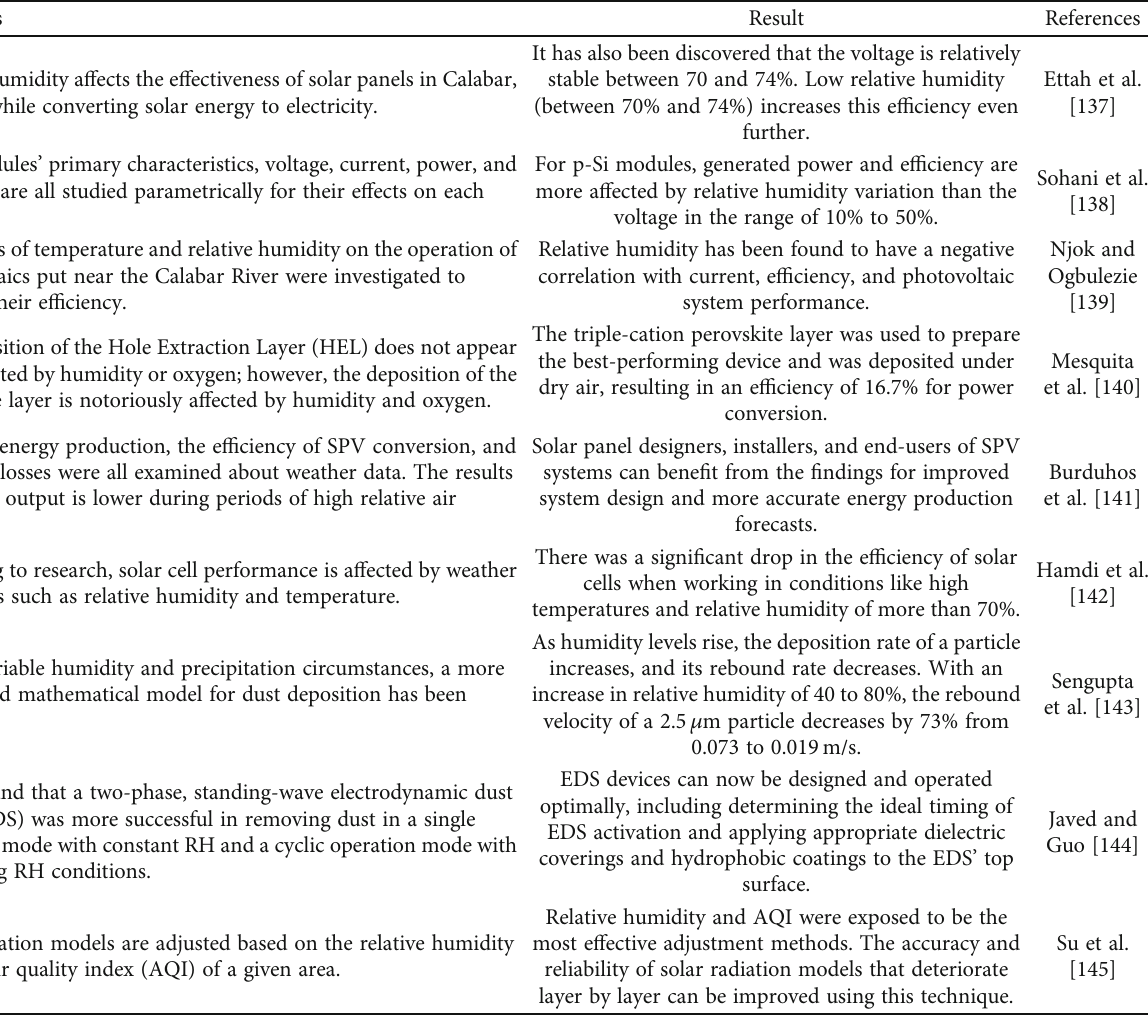
Table 4: Studies on the e ff ect of relative humidity.